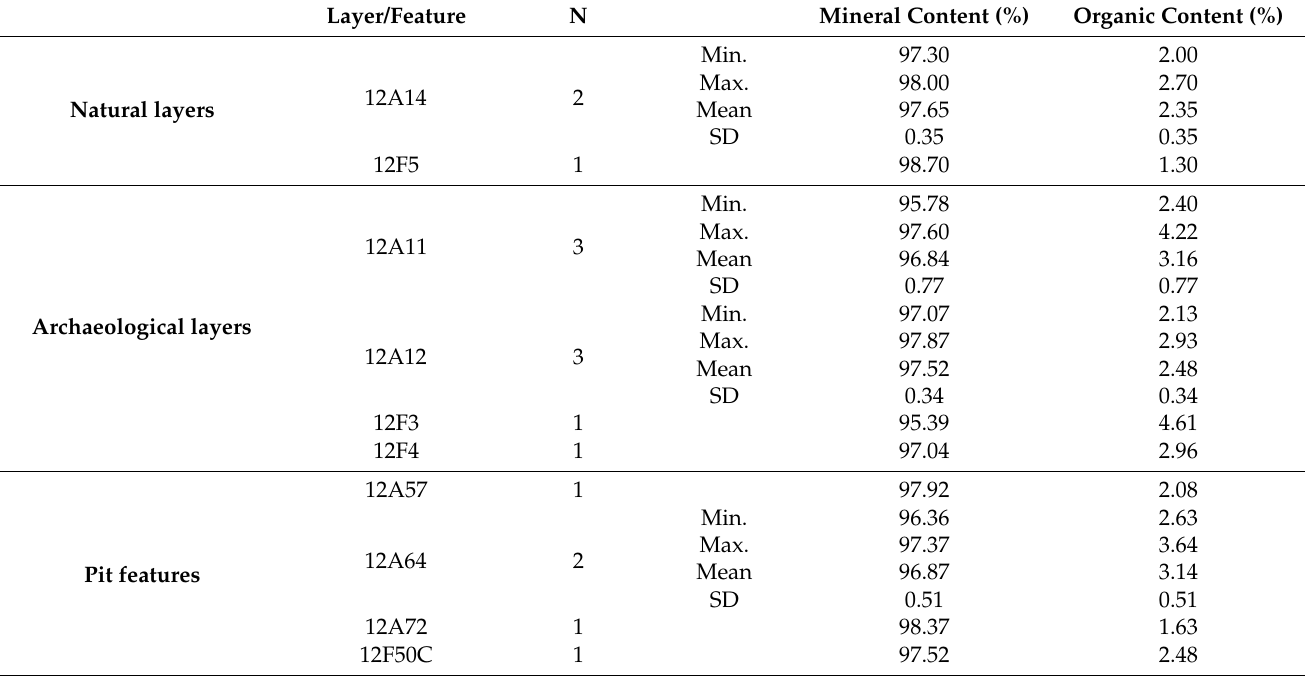
Table 4. Organic matter content data from sediment samples taken in areas 12A and 12F of the Fort Odanak site